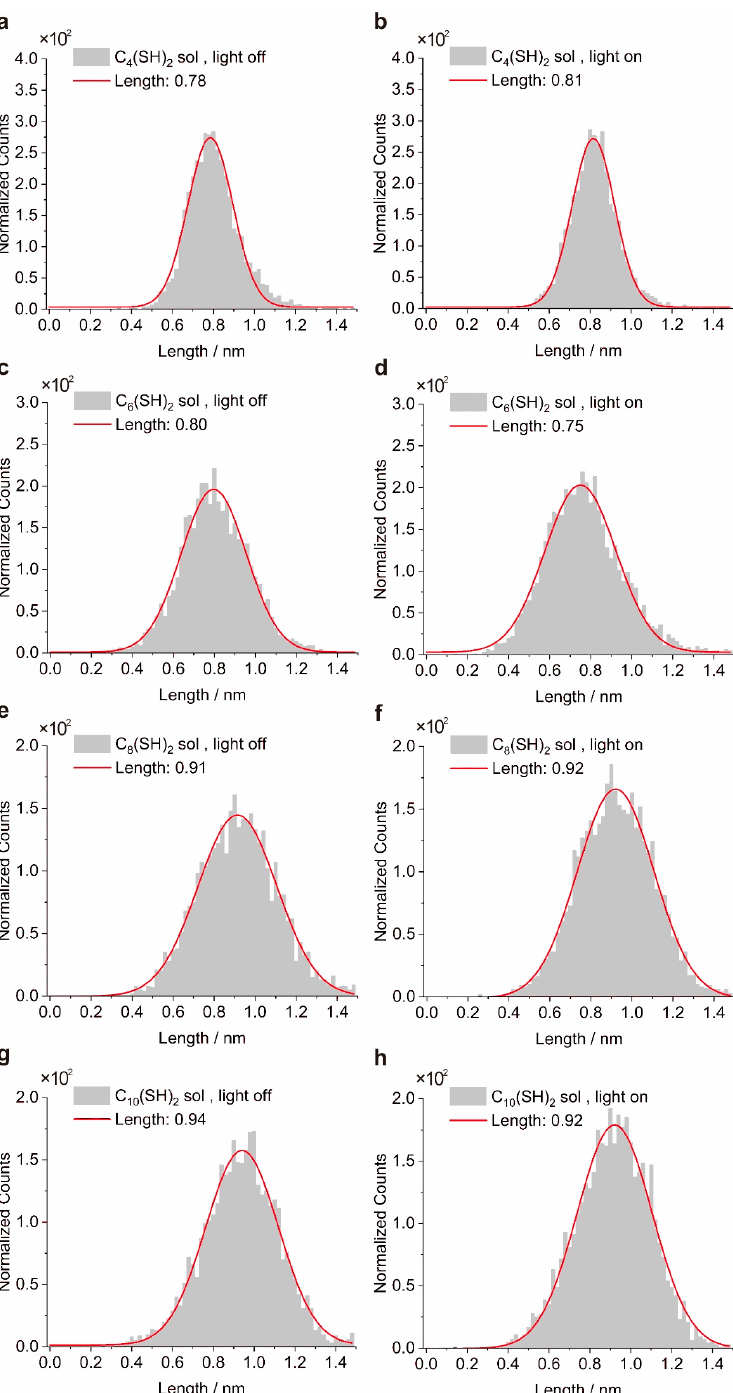
Figure 5. The Gaussian distributions of molecular conductance plateau lengths with light on or off. The data are extracted from 2D conductance histograms in Figure 4. The left column represents plateau length distributions for C 4 (SH) 2 ( a ), C 6 (SH) 2 ( c ), C 8 (SH) 2 ( e ), and C 10 (SH) 2 ( g ) solutions under dark conditions. The right column correspondingly represents plateau length distributions